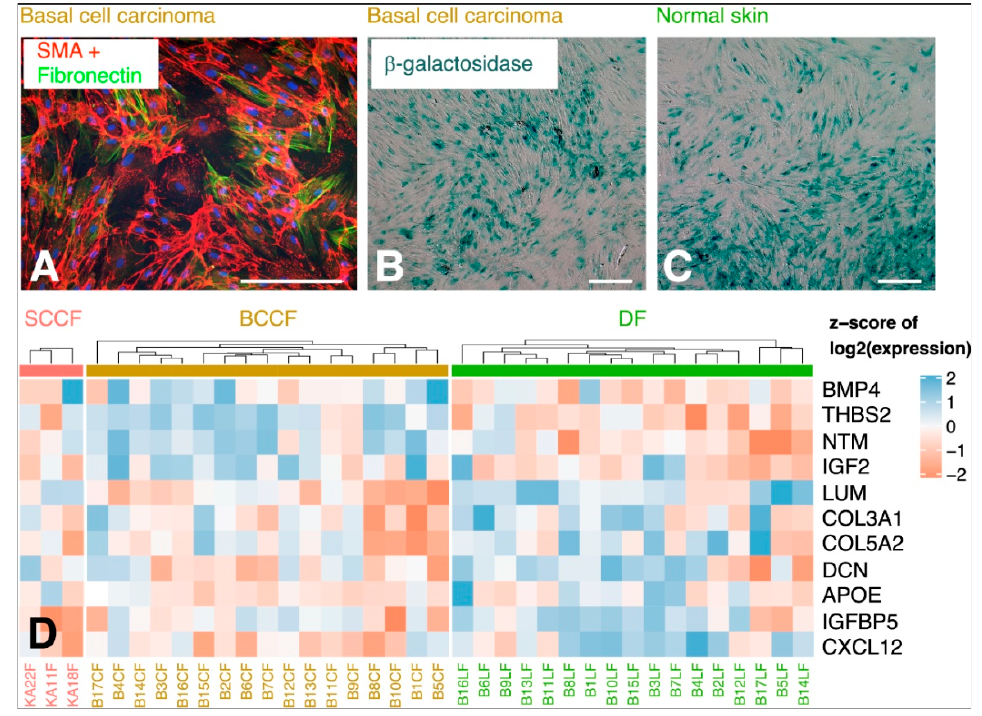
Figure 3. Cultured cancer-associated fibroblasts from basal cell carcinoma and normal skin. Part of fibroblasts isolated from the tumour exhibit α -smooth muscle actin (SMA; green signal). All cells produce fibronectin (red signal). Nuclei were counterstained with 4’,6-diamidino-2-phenylindole (DAPI; blue signal) ( A ). Cultured normal dermal fibroblasts (DF) from the face of an aged donor ( B ) and CAFs from basal cell carcinoma (BCCF) from the face of the same donor ( C ) contain a very high proportion of senescent fibroblasts positive for senescence-associated acid β -galactosidase. The bar is 100 μ m. While the senescent phenotype is present in both fibroblast groups, the cells differ in gene expression of several senescence-associated secretory phenotype (SASP) markers ( D ). The same genes are strongly expressed in CAFs from cutaneous squamous cell carcinoma (SCCF). Table 3. Examples of production of IL-6 by CAFs in different types of cancer and its effect on cancer. E ff ect on Type of Cell